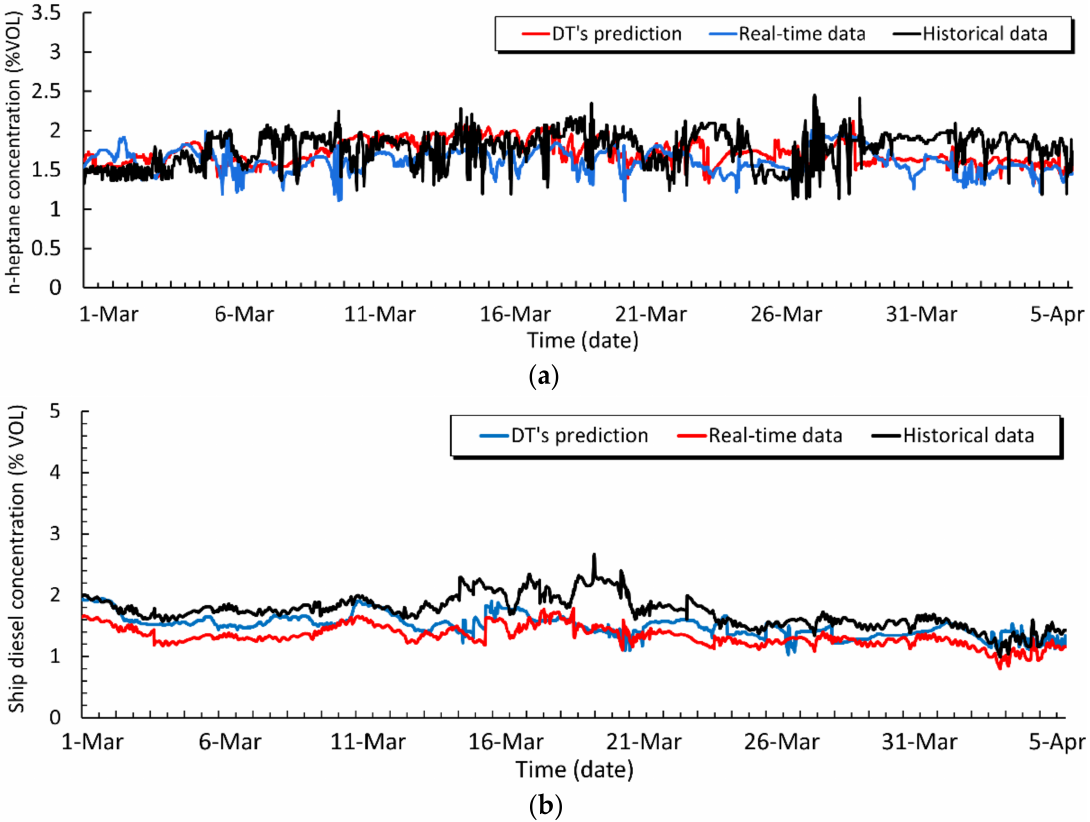
Figure 8. Comparison of concentrations with DT’s prediction, real-time data and historical data. ( a ) Time-varying characteristic of n-heptane concentration. ( b ) Time-varying characteristic of ship diesel